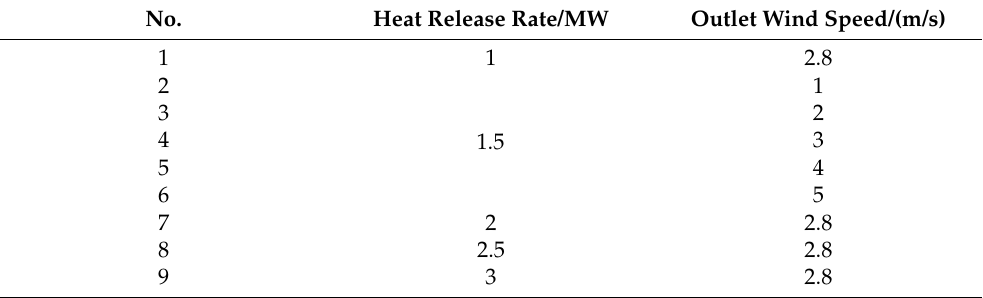
Table 1. Table of different wind speeds.